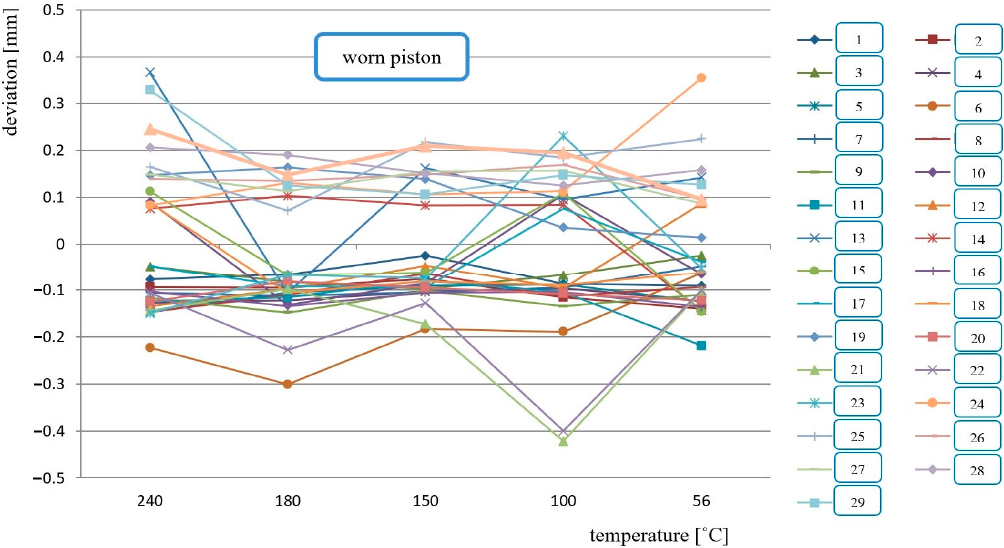
Figure 14. Deviations from the reference measurement (at a temperature of 21 °C) at the individual measurement points of the worn piston.